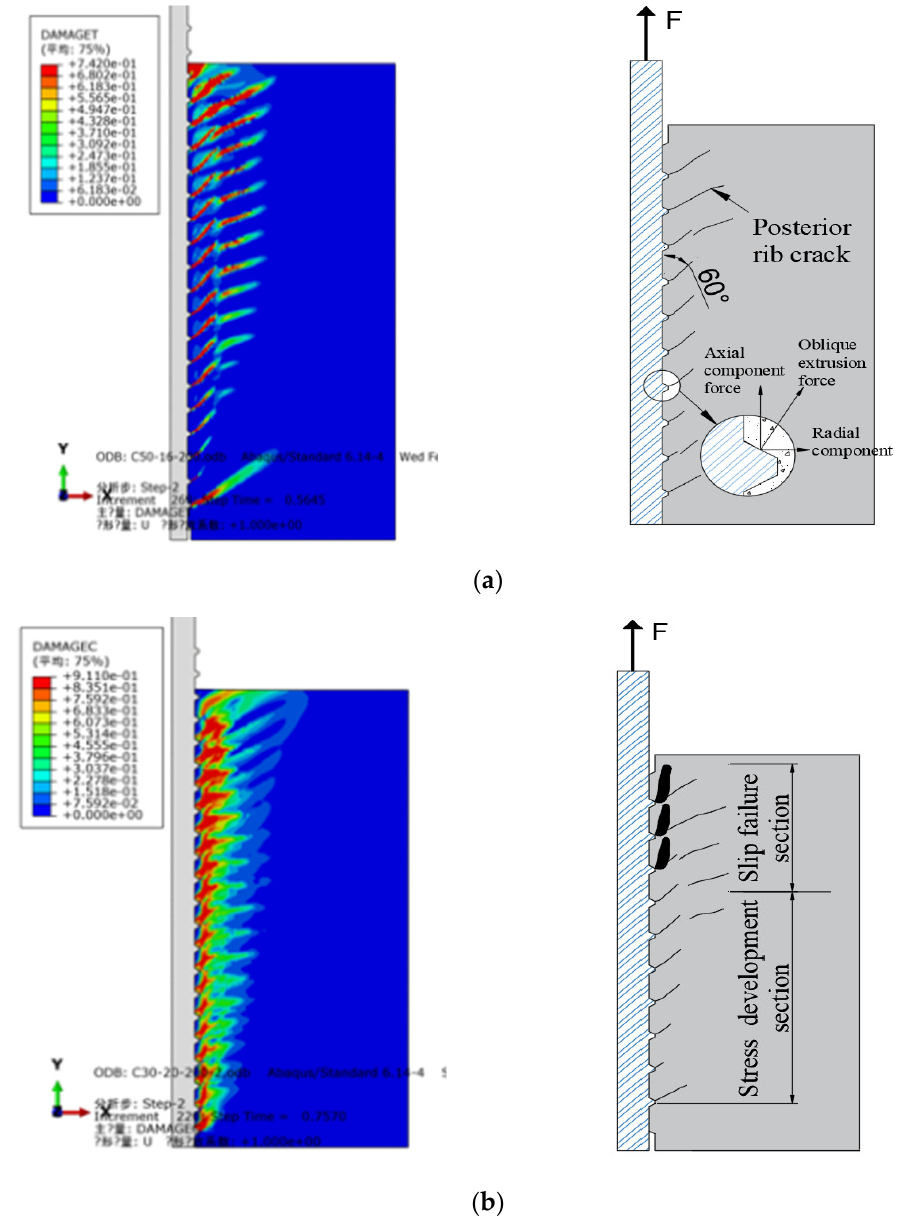
Figure 9. Failure process of the bonding interface. ( a ) Concrete crack development. ( b ) Interface concrete failure. concrete